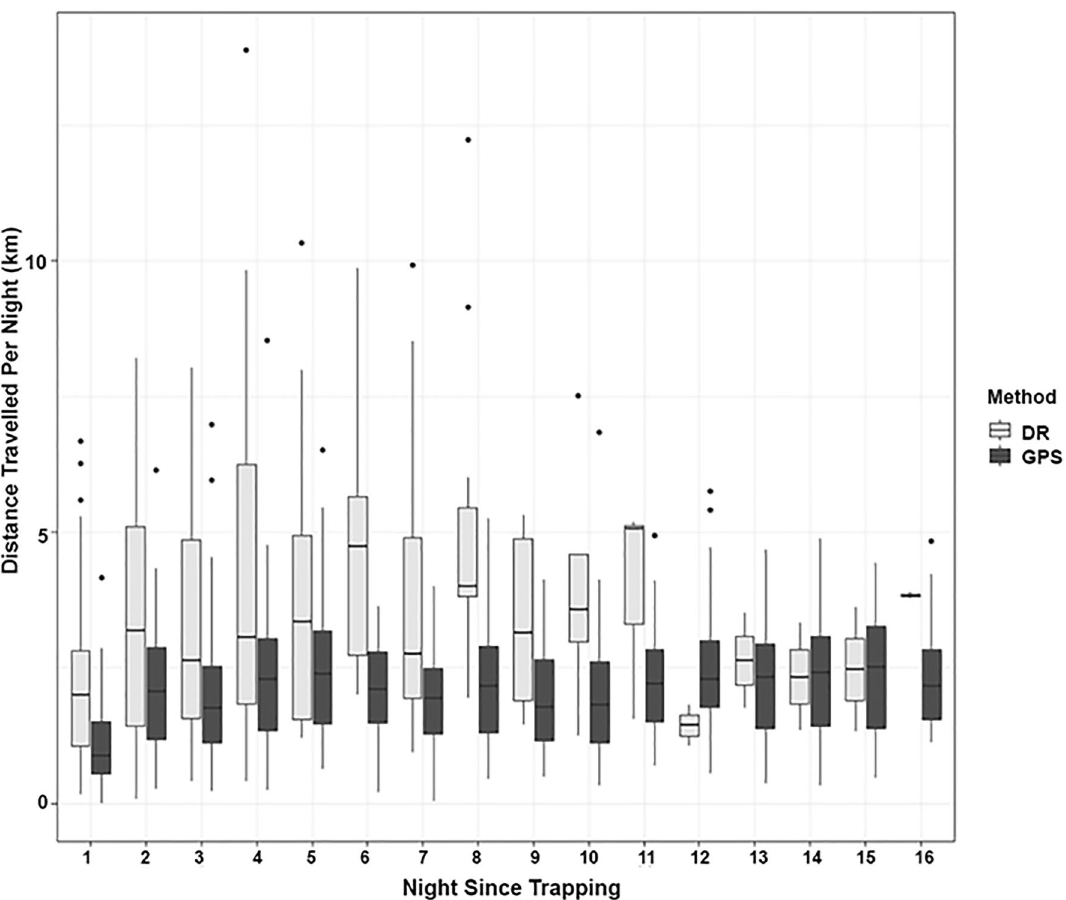
Figure 6. GPS (dark bars) and GPS-enhanced dead-reckoned (light bars) distances travelled per night (km) for 16 nights post trapping. The median is shown as a black horizontal line, with upper and lower quartiles (mean point between maximum/minimum data points and the median) at the top/bottom of the bar. Whiskers (vertical black lines) denote lower and upper 25% of data values. Black points denote outliers (data points 1.5 times lower/higher than the interquartile